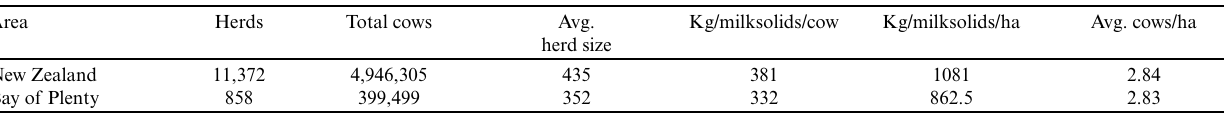
Table 2 . Summary of NZ herd statistics, 2018/2019 (LICNZ and DNZ 2019).